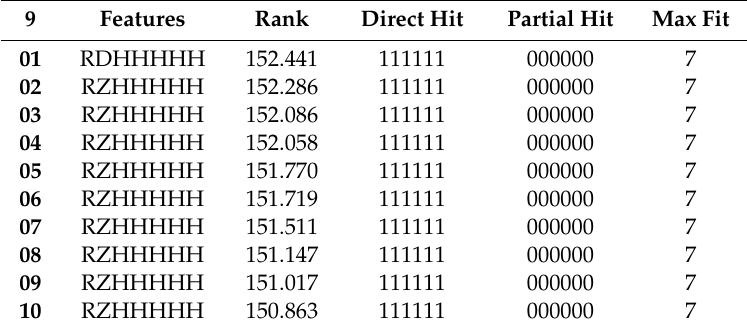
Table 1. The characteristics of the generated pharmacophore model.